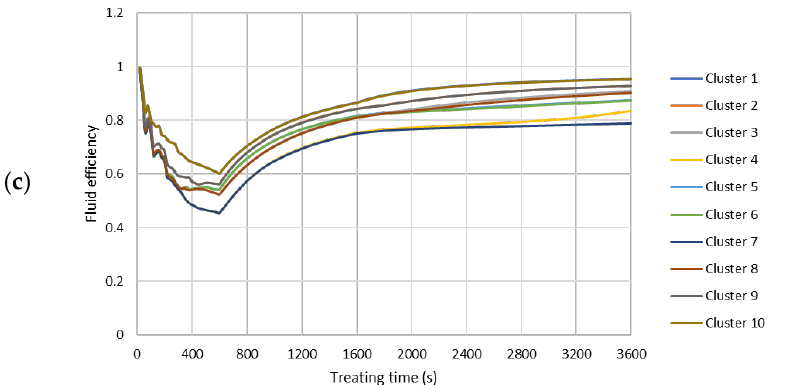
Figure A1. Fluid efficiency of each cluster during the hydraulic fracturing treatment. ( a ) Slick water case. ( b ) NG foam case. ( c ) Hybrid NG/NG foam case.